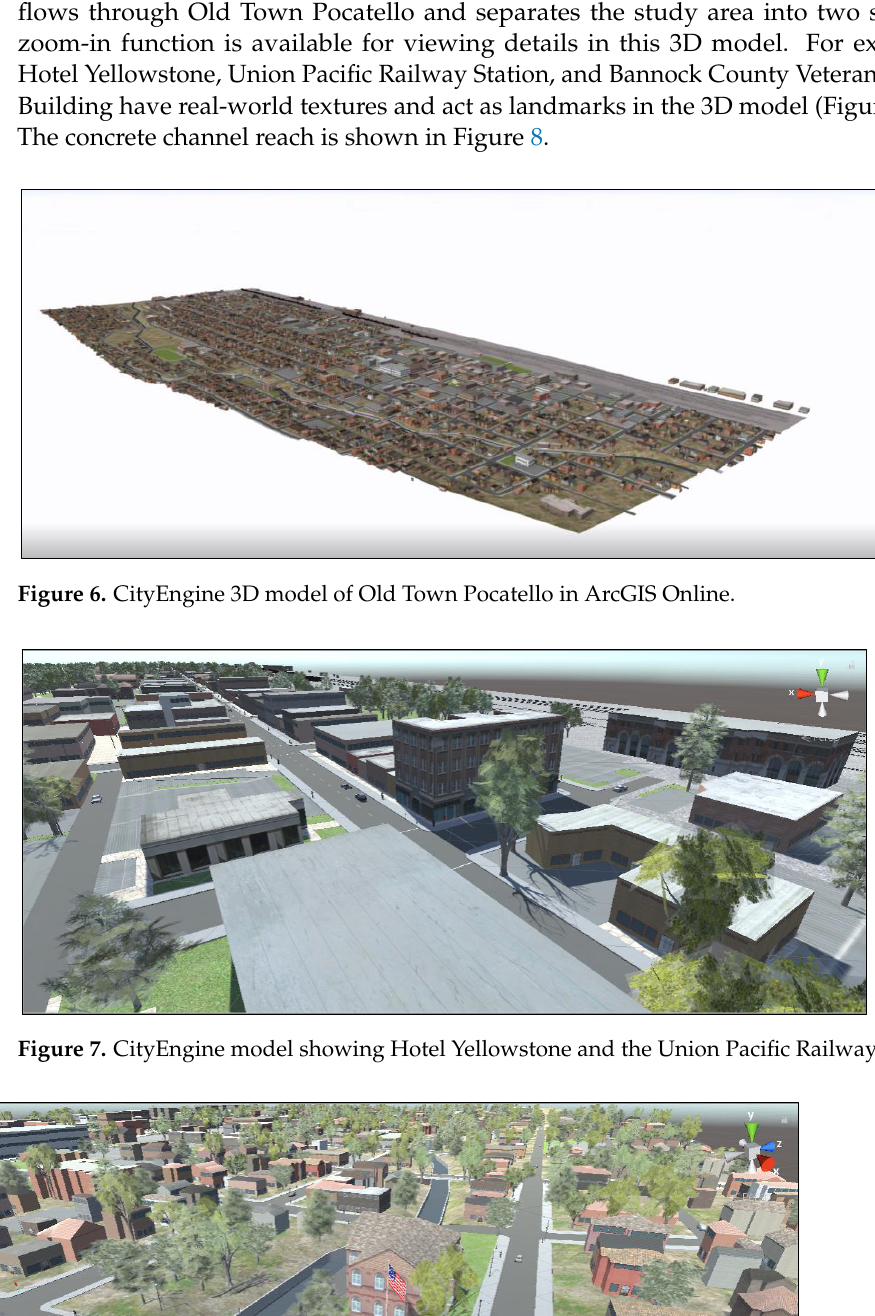
Figure 5. Parking lot types in Pocatello Old Town.